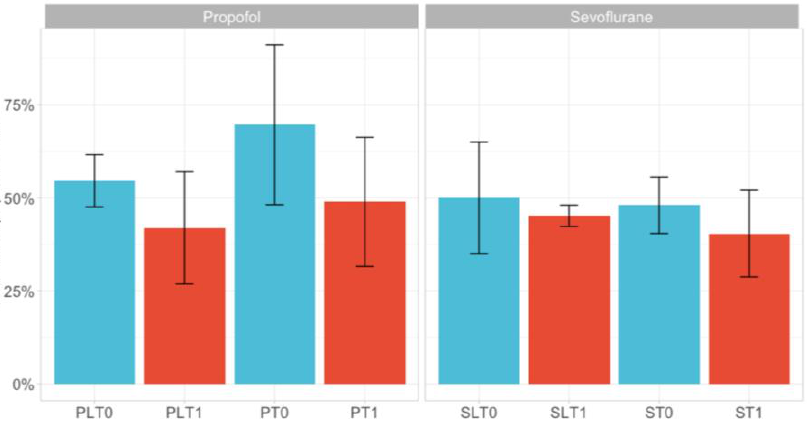
Figure 2. Apoptosis (fluorescence microscopy) in study groups following exposure to TIVA with lidocaine (group PL, before surgery—T0 and after surgery—T1); TIVA (group P, before surgery—T0 and after surgery—T1); sevoflurane with lidocaine (group SL, before surgery—T0 and after surgery—T1); sevoflurane (group S, before surgery—T0 and after surgery—T1) (20 × magnification). The data are represented as the mean +/ − standard